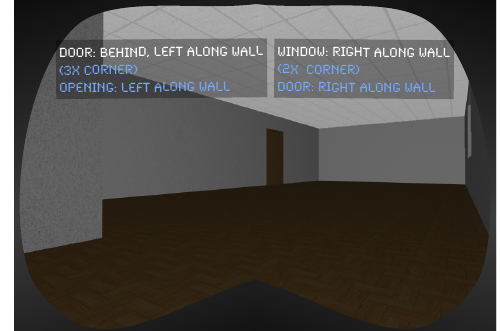
Figure 9: Firefighter perspective with no smoke; the standard route graph is applicable for providing navigation assistance.